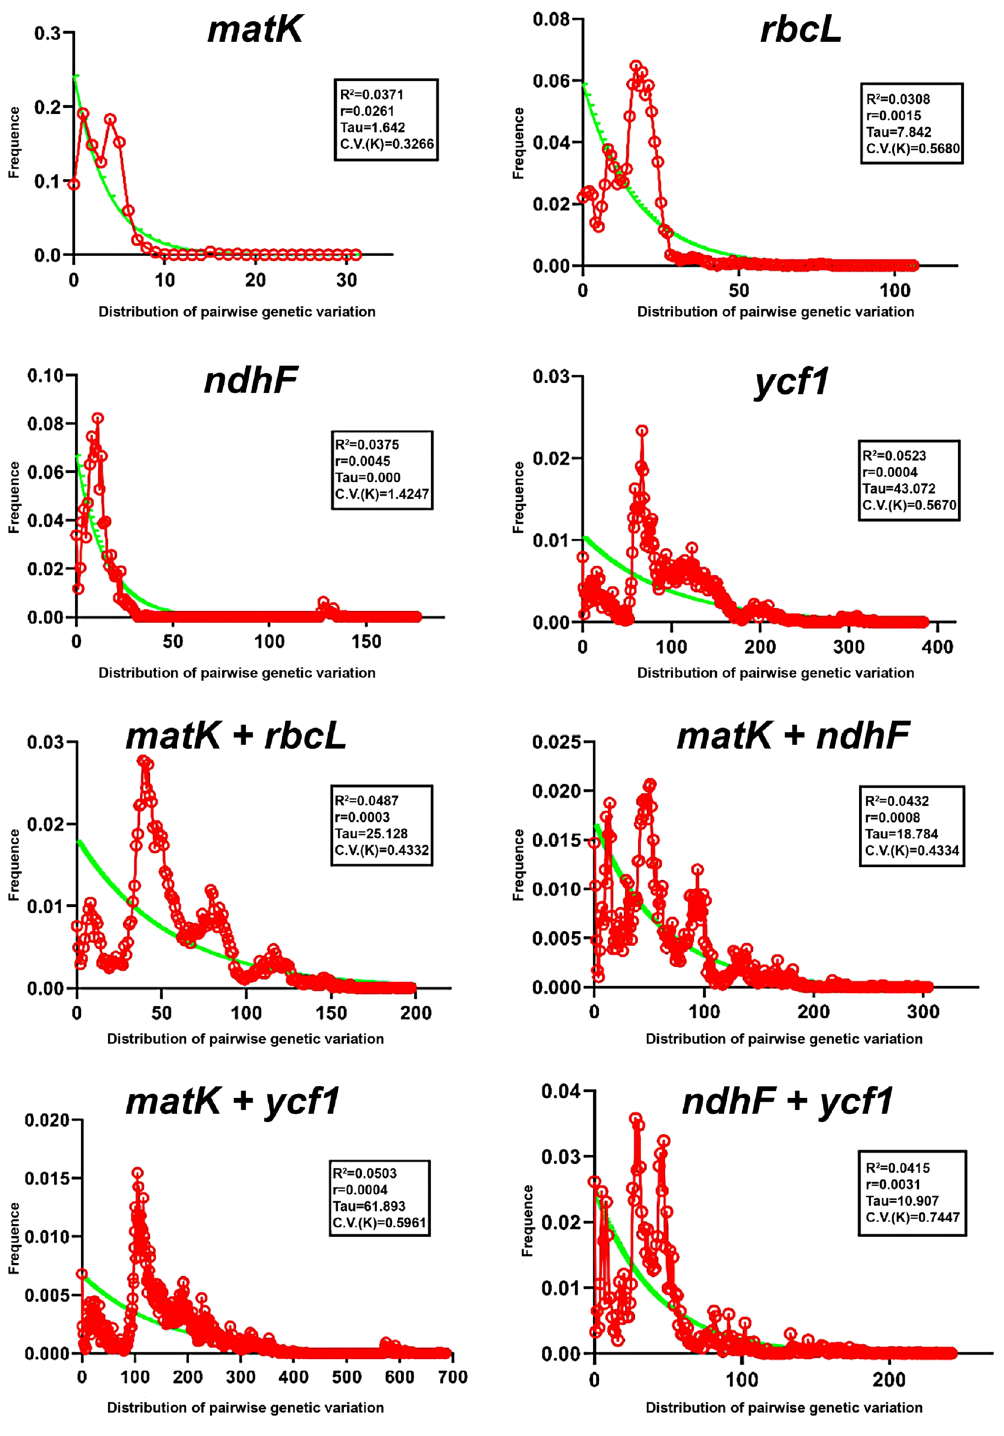
Figure 1. Pairwise mismatch distributions, based on matK , rbcL , ndhF , ycf1 and the combined sequences by DnaSP v5. Note: The X-axis shows the observed distribution of pairwise genetic variation, and the Y-axis shows the frequency. R 2 Ramos-Onsins and Rozas statistics, r Raggedness statistic, Tau Date of the Growth or Decline measured of mutational time, C.V. Coefficient of